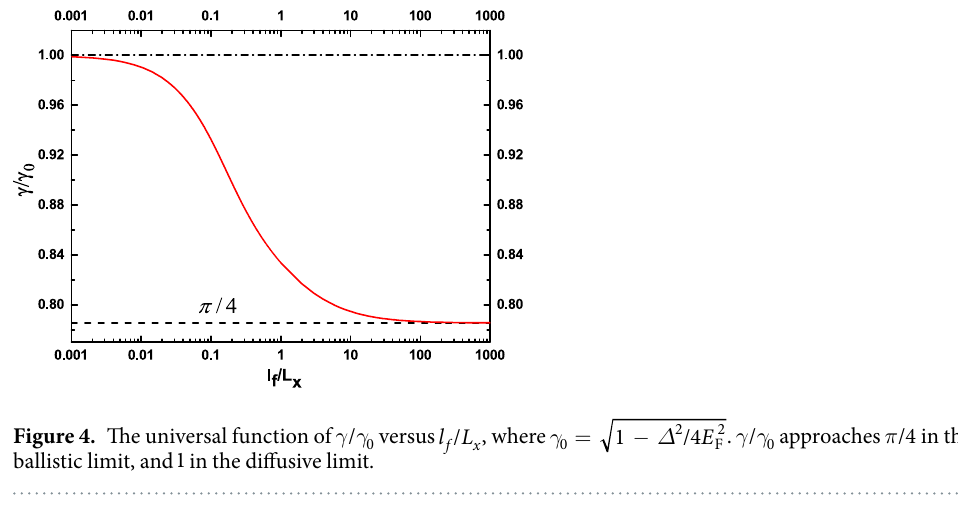
Figure 4. The universal function of γ γ / ballistic limit, and 1 in the diffusive